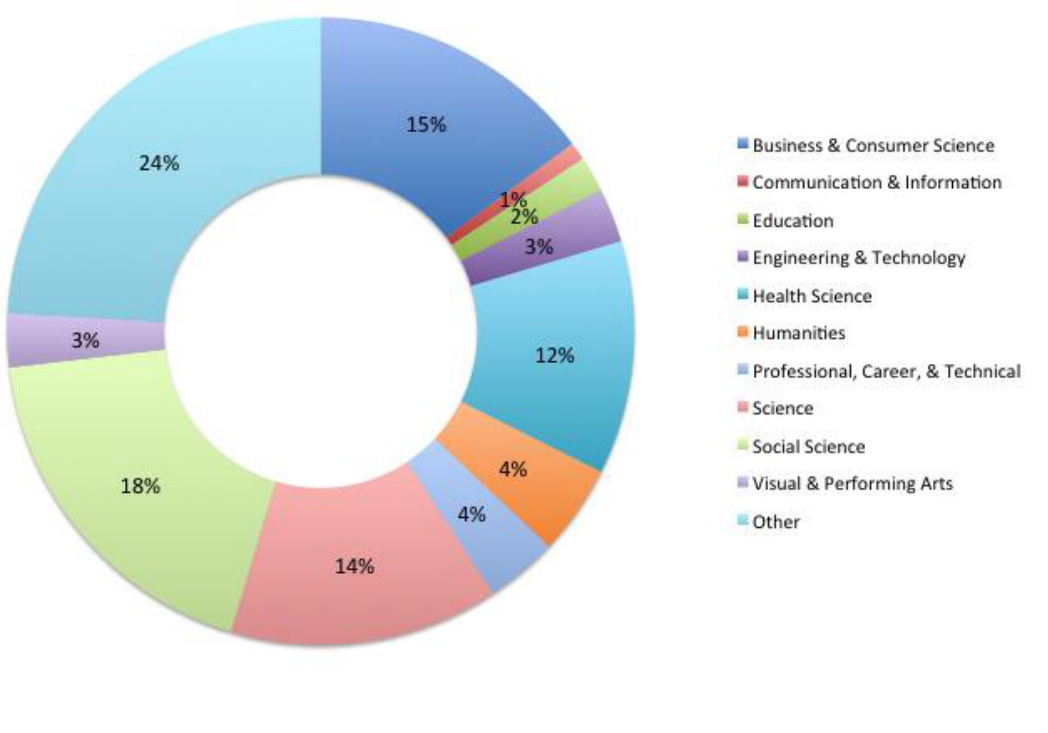
Figure 1. Respondents’ primary area of